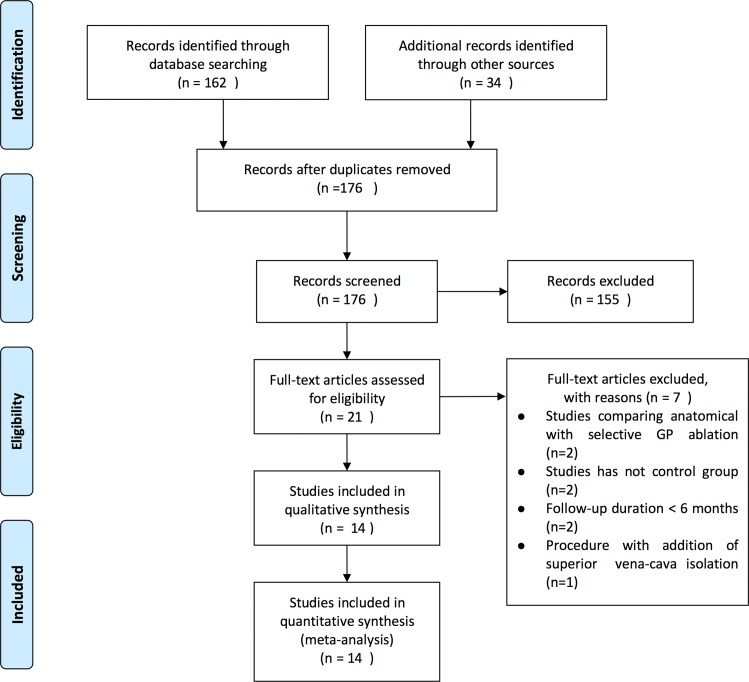
Results of literature search for the meta-analysis